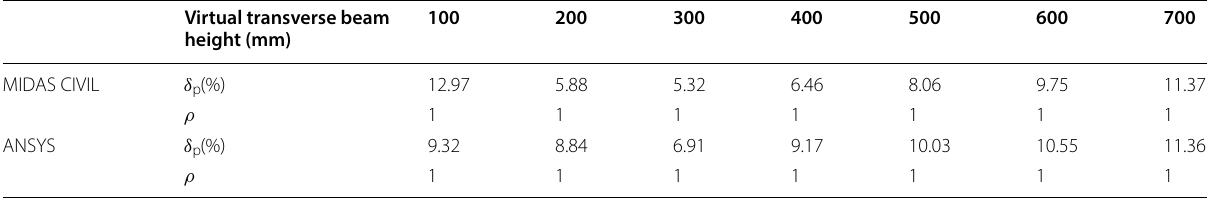
Table 2 Model accuracy for different virtual transverse beam